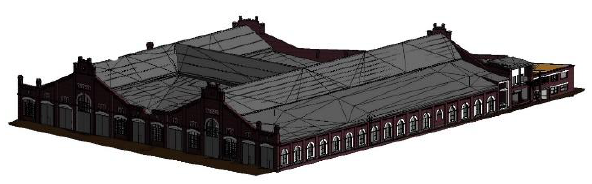
Figure 8. Final model of Metalworker’s